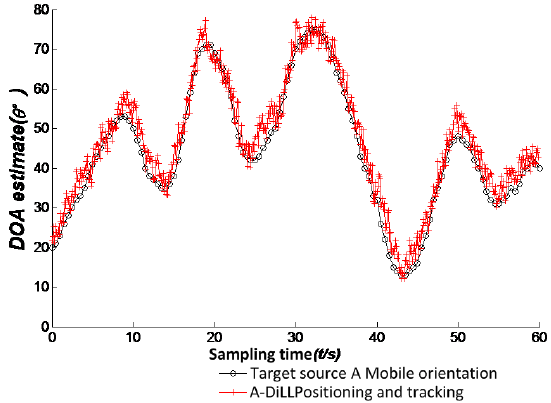
Figure 4. Estimated tracking of Direction of Arrival (DOA) in DILL.